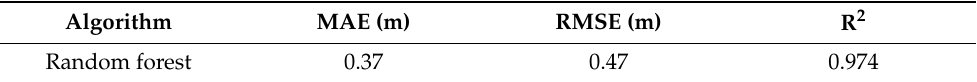
Table 3. Error statistics reported in meters produced by the random forest algorithm.